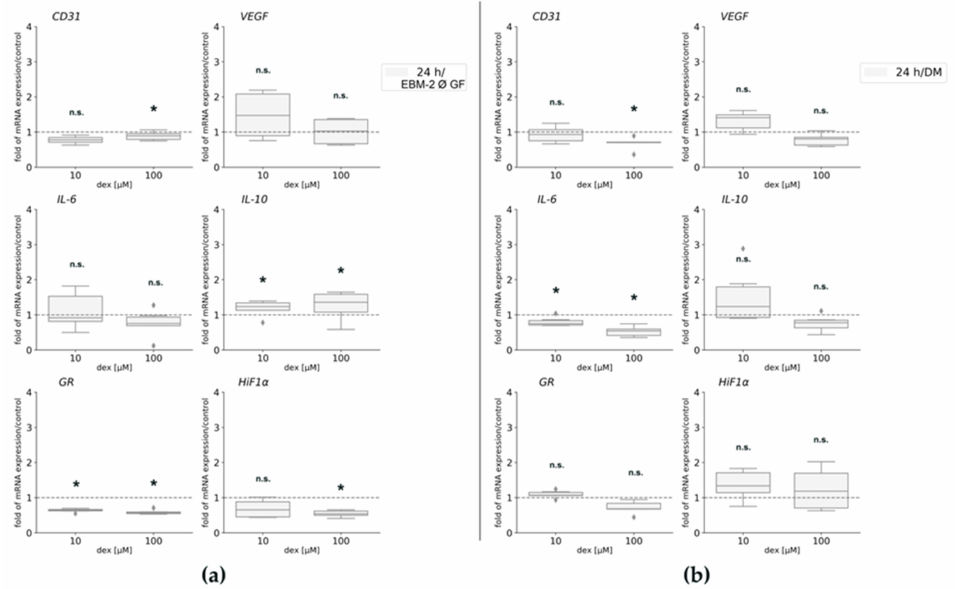
Figure 5. Gene expression analyses of HUVEC maintained in EBM-2 Ø GF ( a ) and in DM ( b ) for CD31 , VEGF , IL-6 , IL-10 , GR , and HiF1 α . The mRNA levels were normalized to GAPDH and calculated as ratios in relation to the untreated control group (interrupted line). Results are presented as medians and quartiles ( n = 3), and p values < 0.05 indicate statistical significance (* p < 0.05), n.s. = non-significant. Outliners are presented as